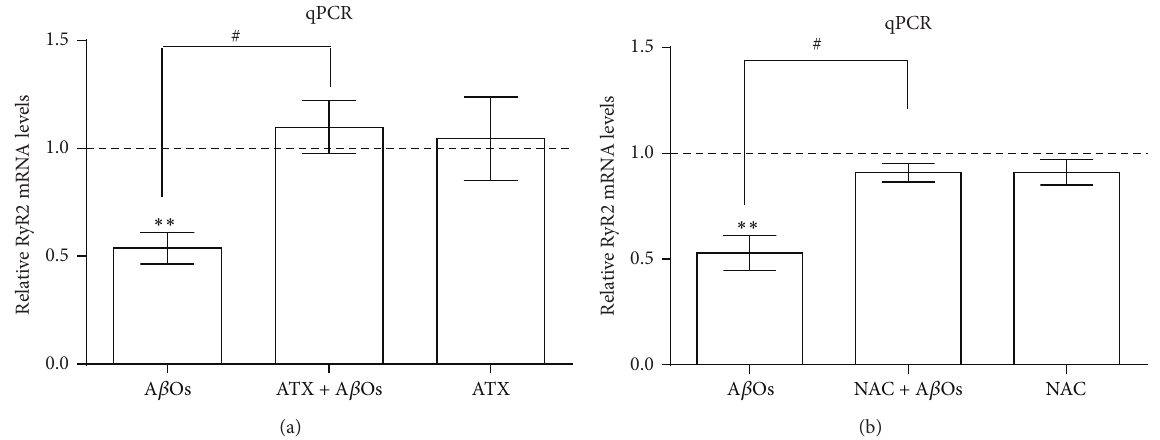
Figure 4: ATX prevents A 𝛽 Os-induced RyR2 mRNA downregulation. Hippocampal cultures were preincubated with 0.1 𝜇 M ATX (a) or 10mM of NAC (b) for 1.5 h or 30 minutes, respectively, before incubation for 6 h with 500 nM A 𝛽 Os. Relative RyR2 mRNA levels were determined with qPCR, normalized to 𝛽 -actin mRNA levels, and expressed as fold over control. Values represent mean ± SE ( 𝑛 = 6 ) from experimentsperformedinculturesfromsixdifferentanimals;eachconditionwastestedintriplicate.Statisticallysignificantdifferencesamong experimental conditions were evaluated by one-way ANOVA followed by Bonferroni’s multiple comparison test ( ∗∗ 𝑝 < 0.001 compared to control; # 𝑝 < 0.05 compared to indicated